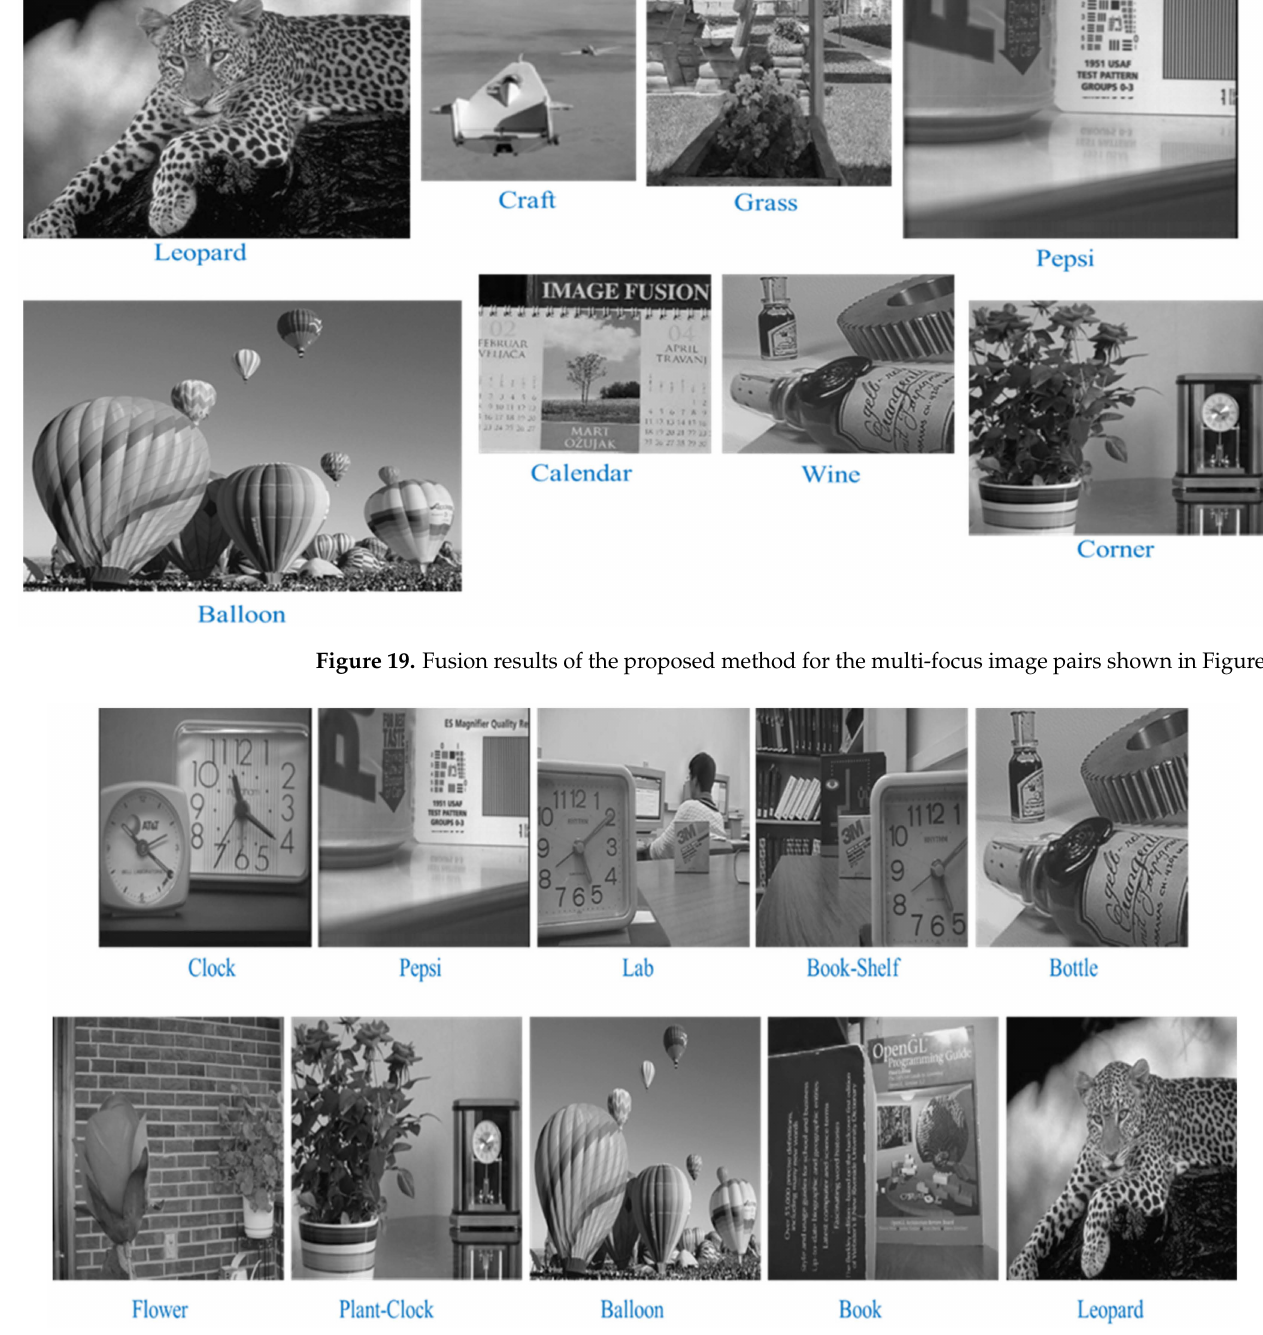
Figure 20. Fusion results of the proposed method for the multi-focus image pairs shown in Figure 18. Table 11. The average objective evaluation of different techniques on multi-focus image pairs